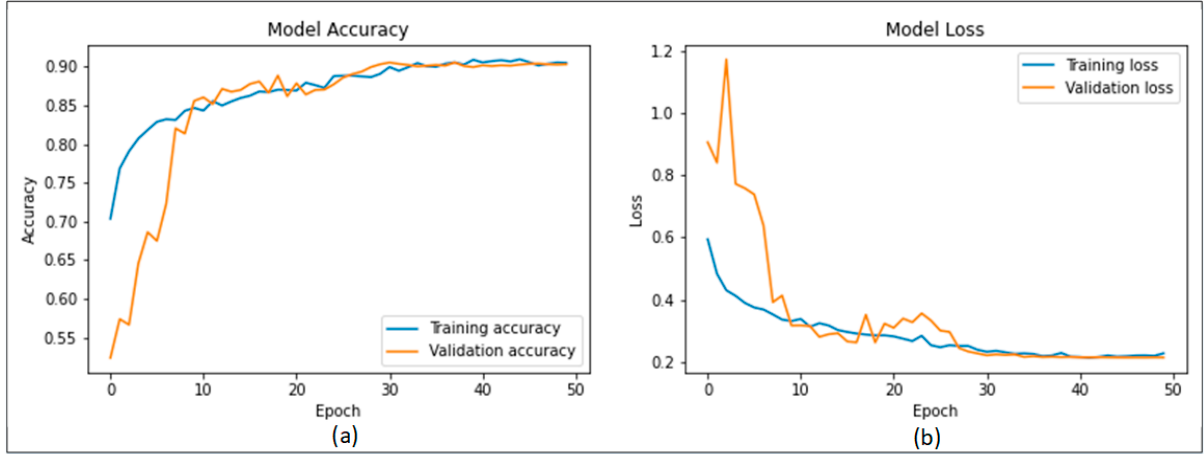
Figure 8. Training plots of Modified MobileNetV2; ( a ) accuracy plot, ( b ) loss plot.